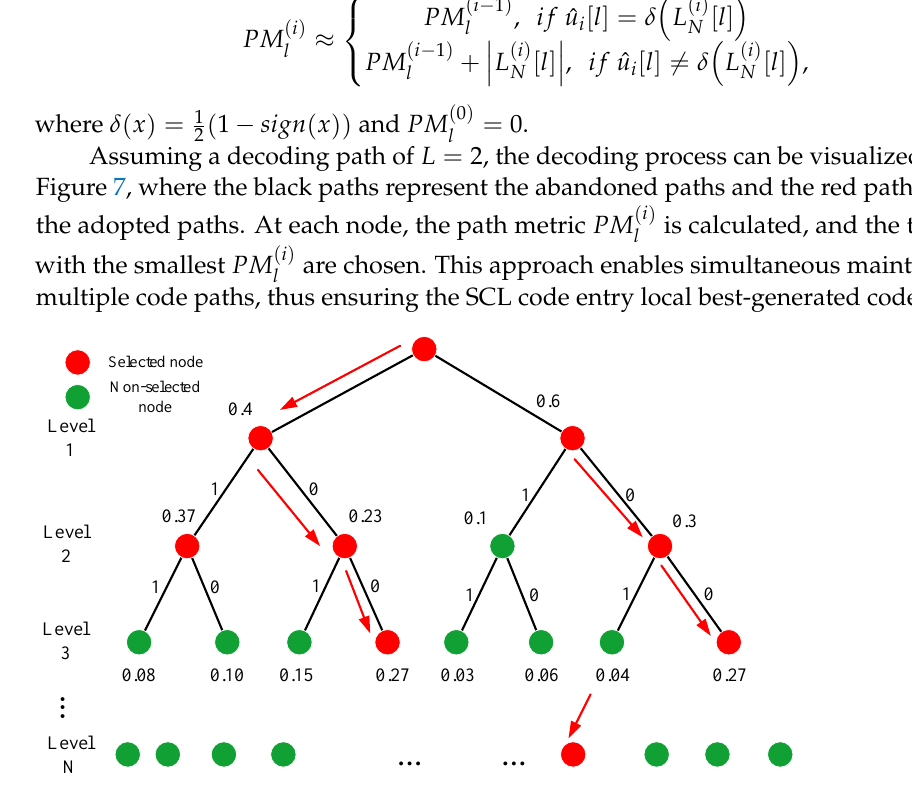
Figure 7. Decoding process of SCL